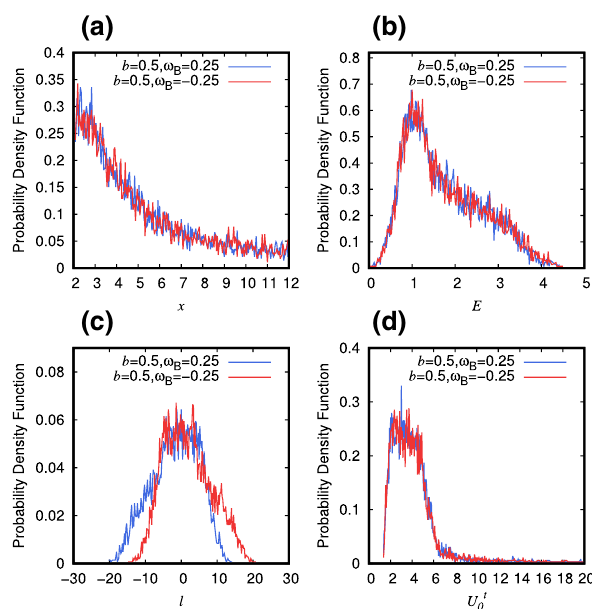
Fig. 13 The probability density functions of falling into quantum- corrected Schwarzschild black holes with respect to x , E , l and U t